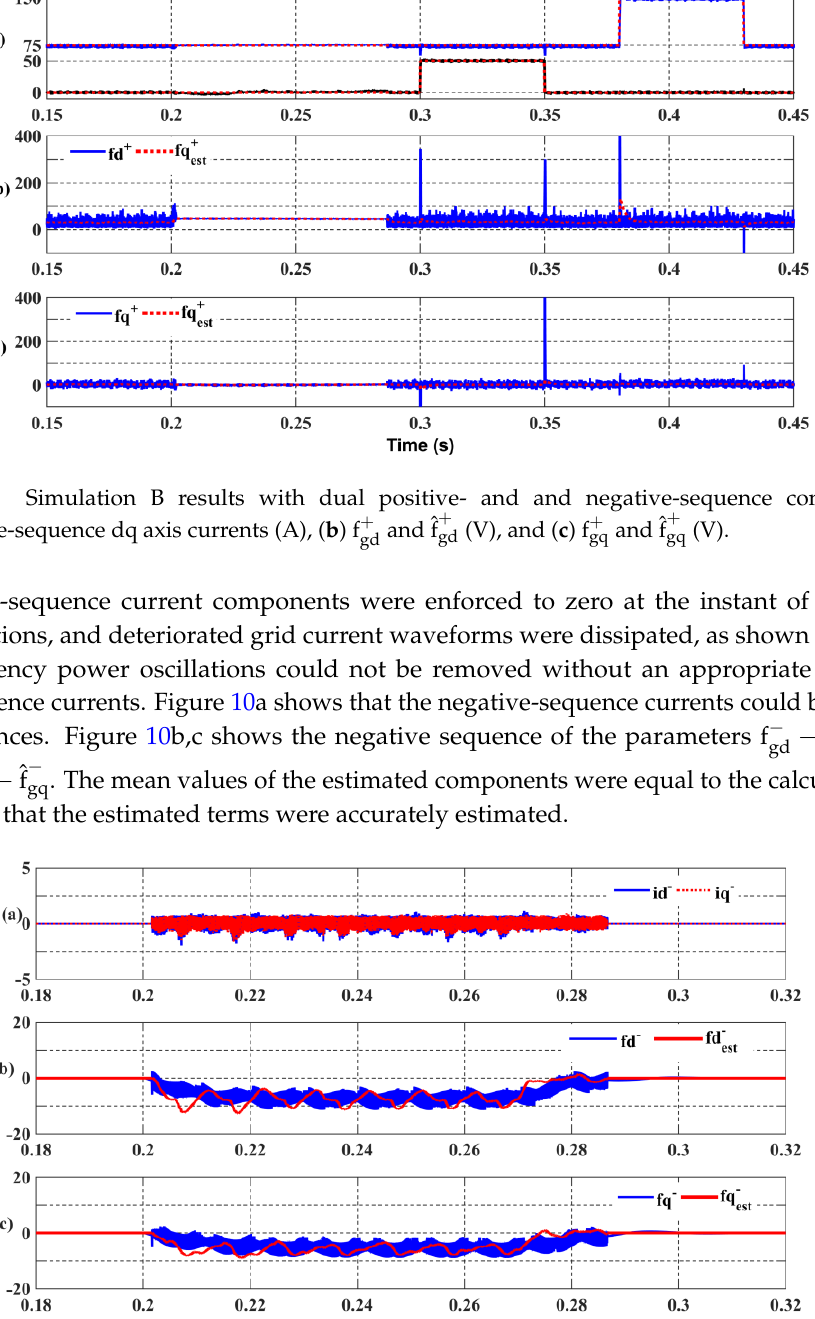
− − ˆf − and ˆf gd (V), and ( c ) f gq and gq gd